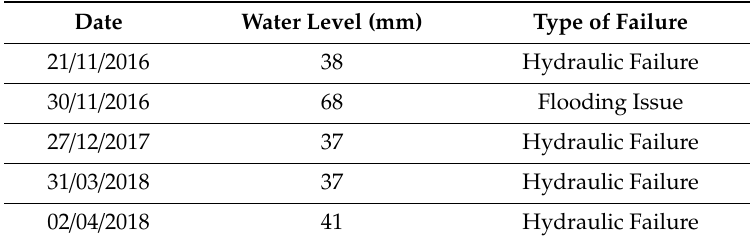
Table 6. Data for the water levels reaching one of the two levels of failure: ( a ) hydraulic failure (0.40 –0.60 m); ( b ) flooding issue ( > 0.60